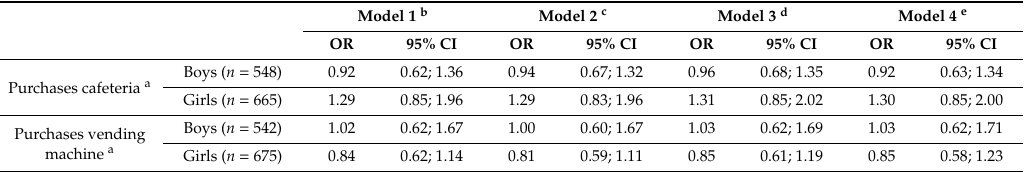
Table 5. Mixed logistic regression analyses on the e ff ect of the intervention (ref. group is control group) on changes in purchase behaviour.